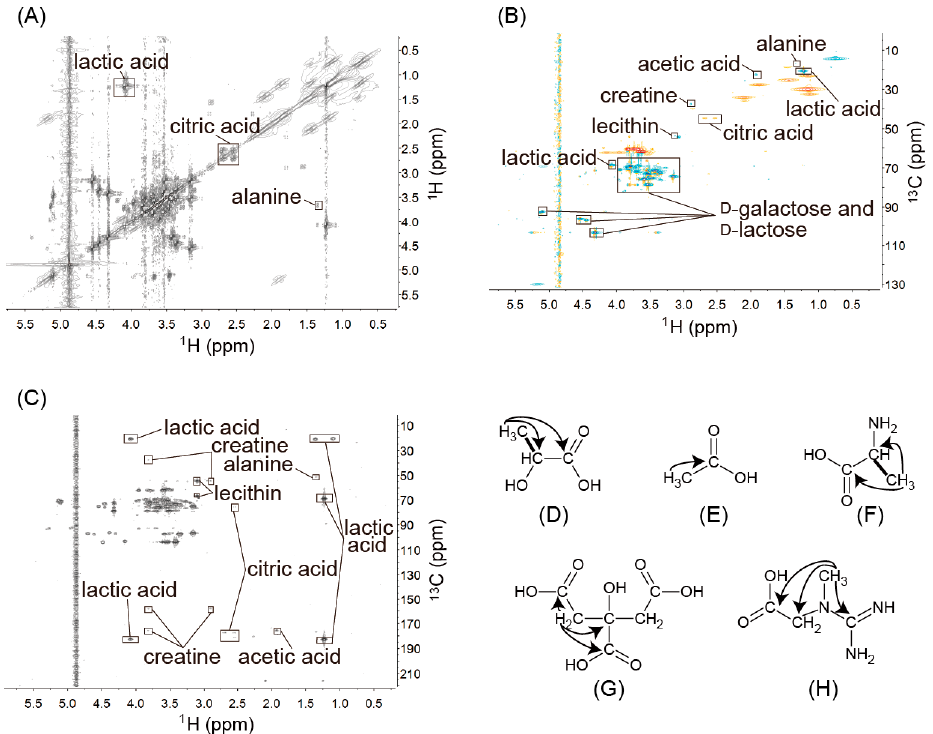
Figure 2. ( A ) The 1 H– 1 H COSY NMR spectrum of yogurt. ( B ) The 1 H– 13 C HSQC NMR spectrum